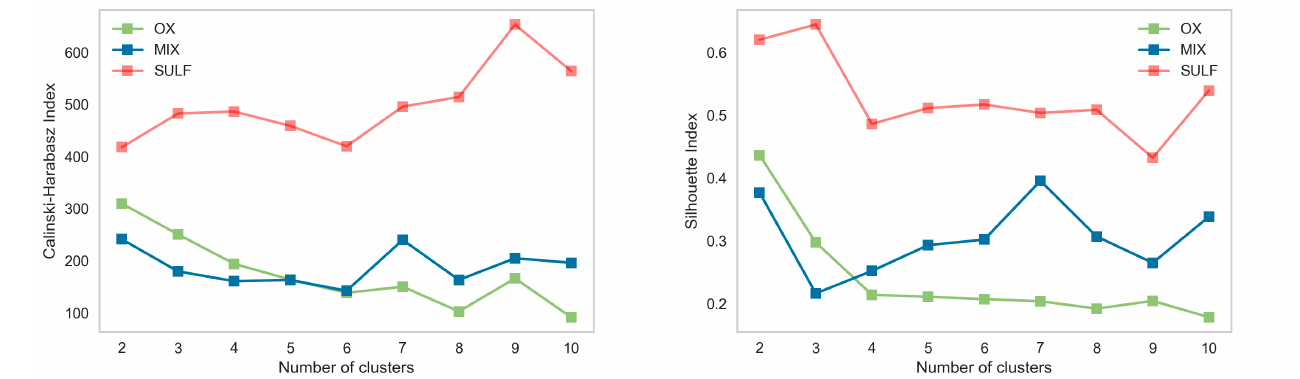
Figure 7. Line graph for Calinski–Harabasz index and silhouette coefficient.